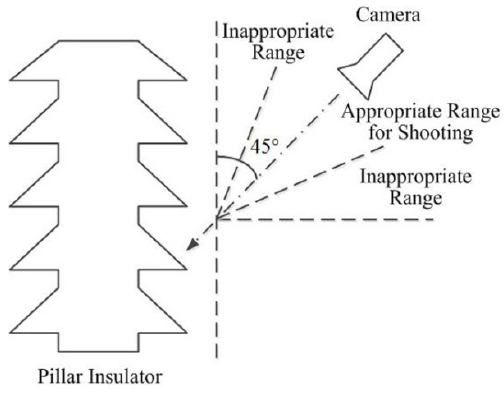
Figure 3. Schematic diagram of the camera angle.